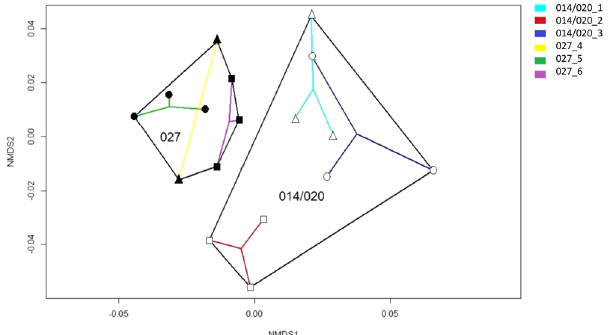
Figure 3. Non-Metric Multidimensional Scaling (NMDS) analysis for samples cultured in WCAB (Wilkins Chalgren Anaerobe Broth) after a five day incubation period (R, vegan package). Black lines separate two C. difficile ribotypes, whereas colored lines indicate different C. difficile strains.